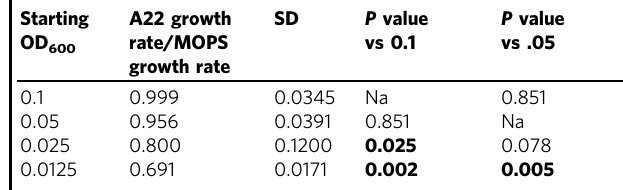
Table 1 Increased cell density allows cells to grow in